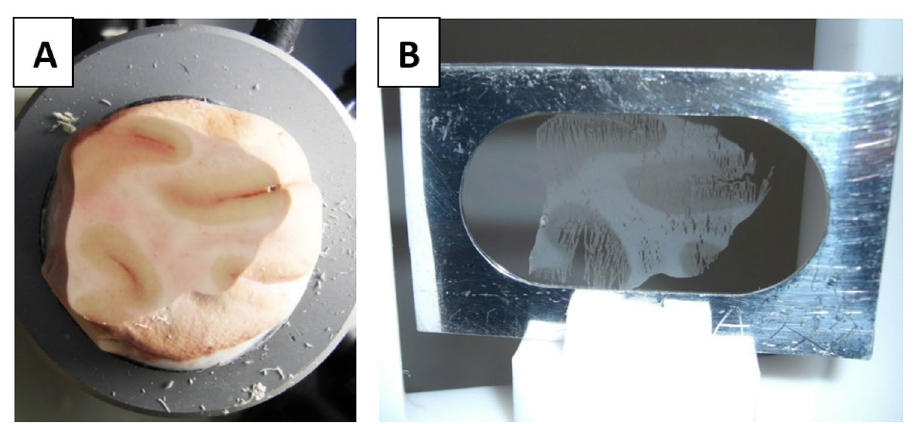
Figure 9. Cryotome brain sample: ( A ) sample on cryotome holder; ( B ) 10 µm slice attached to the sample frames made from a self-supporting d = 0.9 µm polyethylene cling film, fixed to an outer 300 μm thick aluminum target